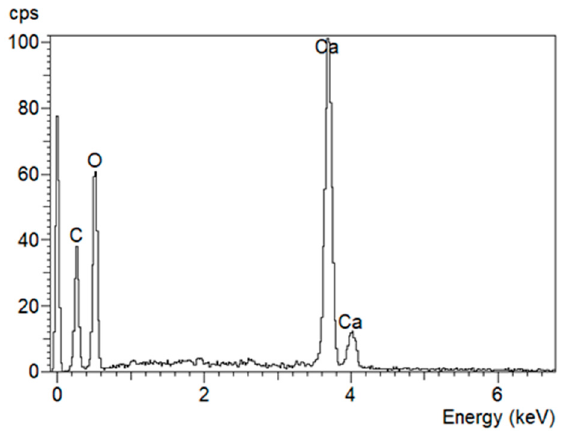
Figure 6. EDX analysis of the deposited film.